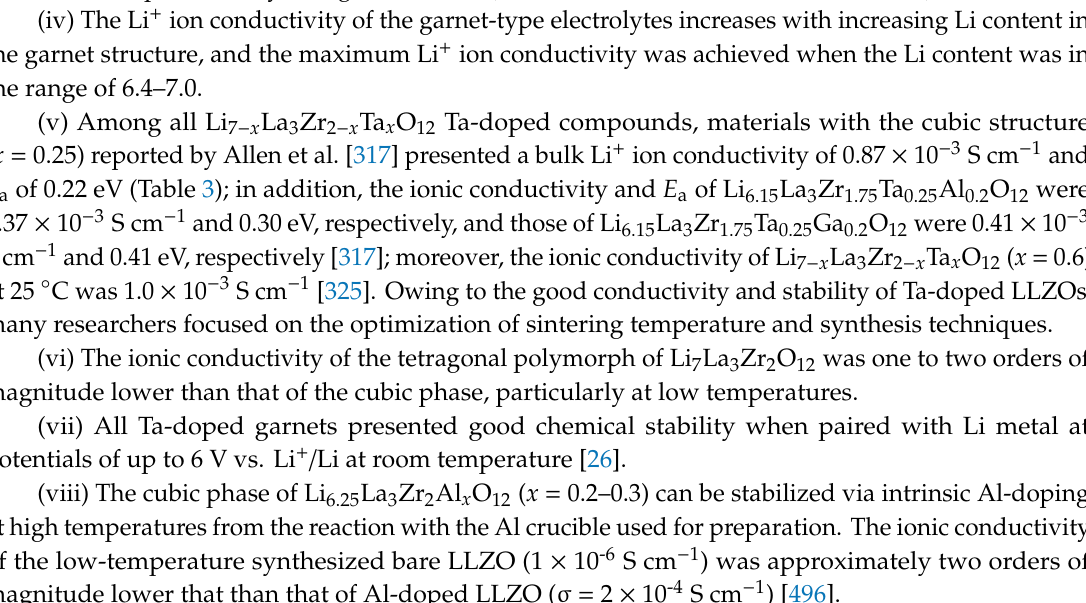
Figure 22. ( a ) Crystal structure of cubic Li 7 La 3 Zr 2 O 12 (LLZO) and ( b ) Wyckoff positions of the Li + ions. The centers of the tetrahedral and octahedral sites are denoted as 24 d and 48 g sites, respectively, and the 96 h sites are slightly displaced off the 48 g sites; LiO 6 and LiO 4 connections and two possible Li migration pathways (A and B); pathway B is the most likely Li + ion mechanism migration in LLZO. Reproduced with permission from [73]. Copyright 2019 Royal Society of Chemistry.